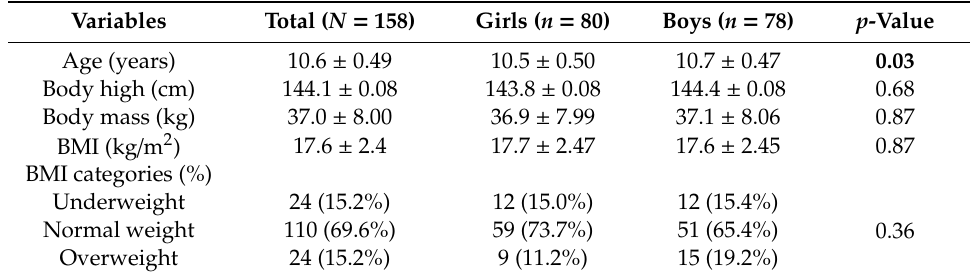
Table 1. Descriptive statistics (mean, standard deviation and frequency) of the anthropometric indicators / measurements of the children by